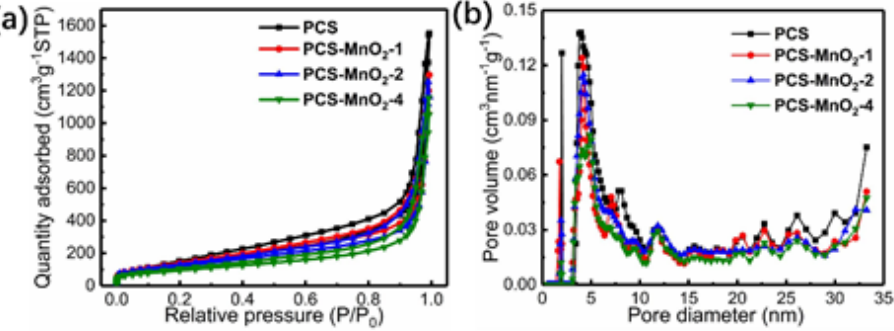
Figure 4. ( a ) N 2 adsorption / desorption isotherms and ( b ) Pore size distributions of PCS and PCS-MnO 2 composites, respectively.